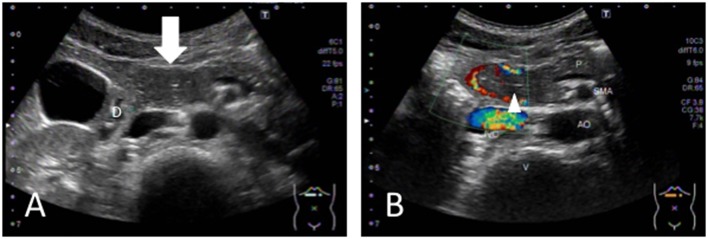
(A) The tumor-like region is identified (white arrow), which is located as part of the DU. (B) The blood vessel around the region and the central echogenic line (appearing to be the mucosa) are visualized. D, duodenum; P, pancreas; AO, aorta; IVC, inferior vena cava; SMA; superior mesenteric artery; V, vertebral column.